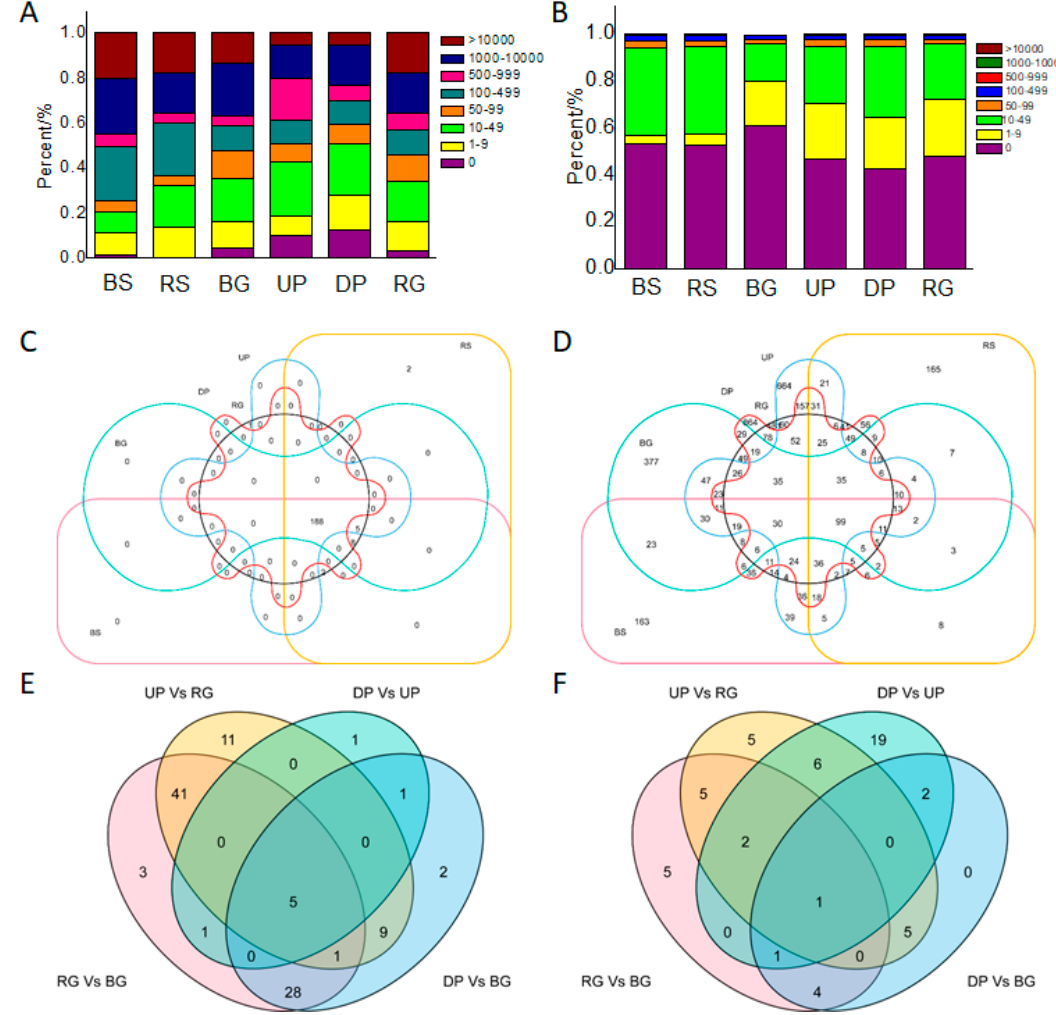
Figure 5. General information of miRNAs in different apple trees. ( A ) Expression levels of identified known miRNAs with their read content frequencies in each library; ( B ) expression levels of identified novel miRNAs with their read content frequencies in each library; ( C ) Venn analysis of identified known miRNAs; ( D ) Venn analysis of identified novel miRNAs; ( E ) Venn analysis of differentially expressed known miRNAs between BG, UP, DP, and RG; ( F ) Venn analysis of differentially expressed novel miRNAs between BG, UP, DP, and RG.